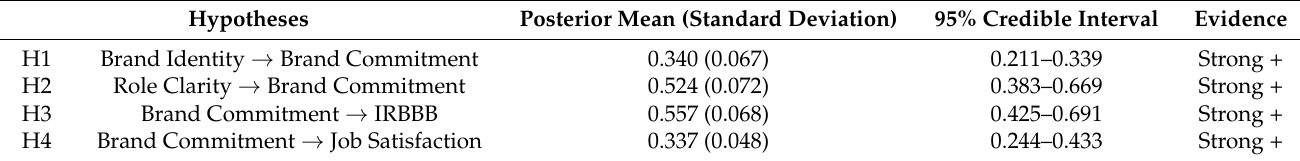
Table 4. Results from the MCMC regarding the four hypothesized latent